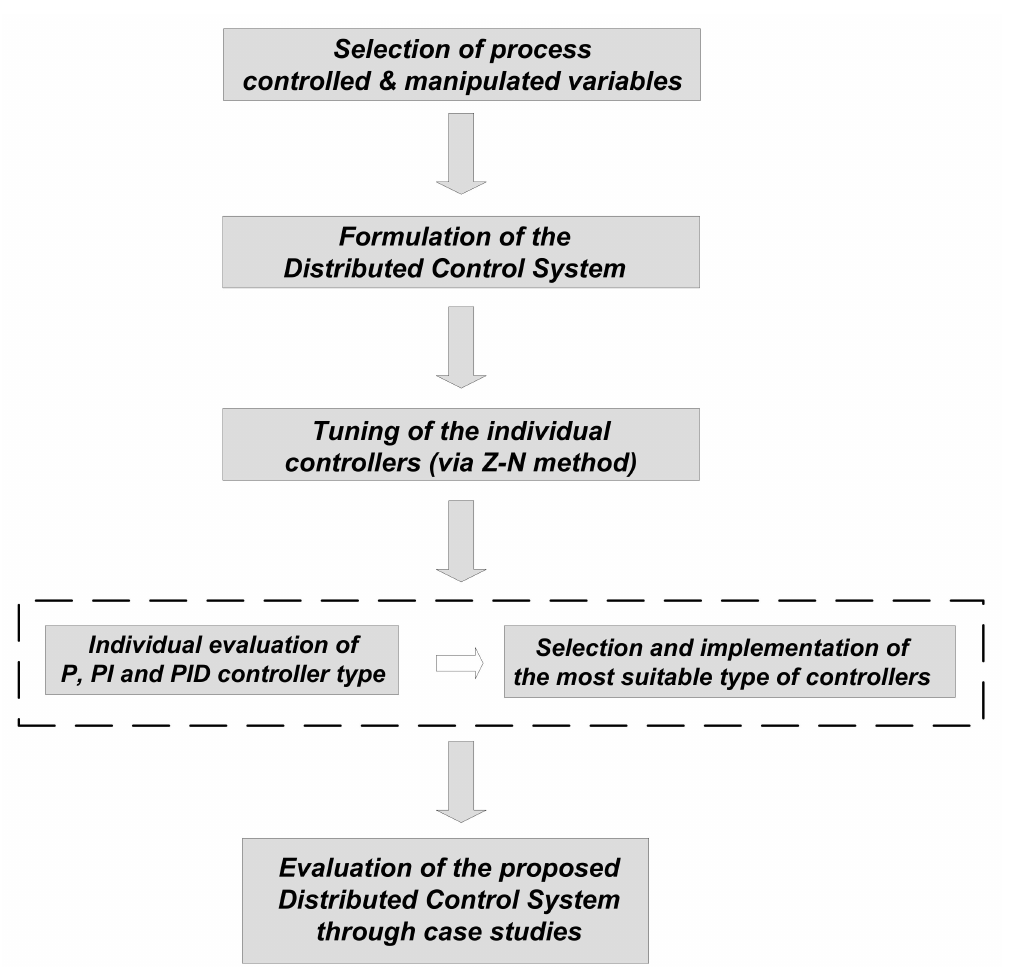
Figure 2. Implementation of the proposed control structure and related